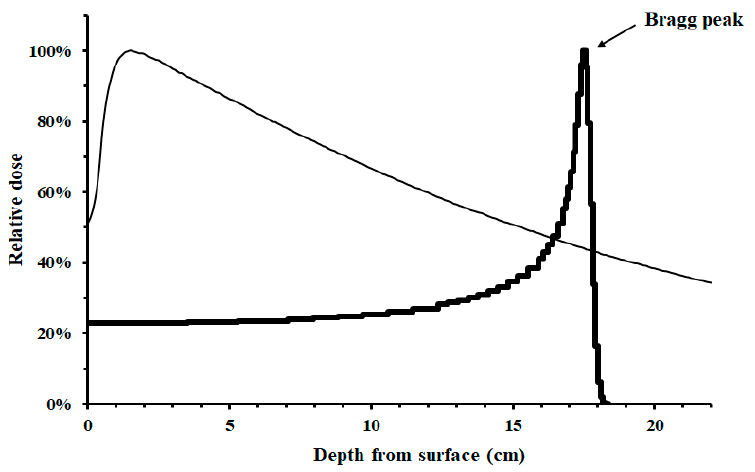
Figure 1. Illustrative dose distribution of proton therapy (bold line) vs. photon therapy (thin line).